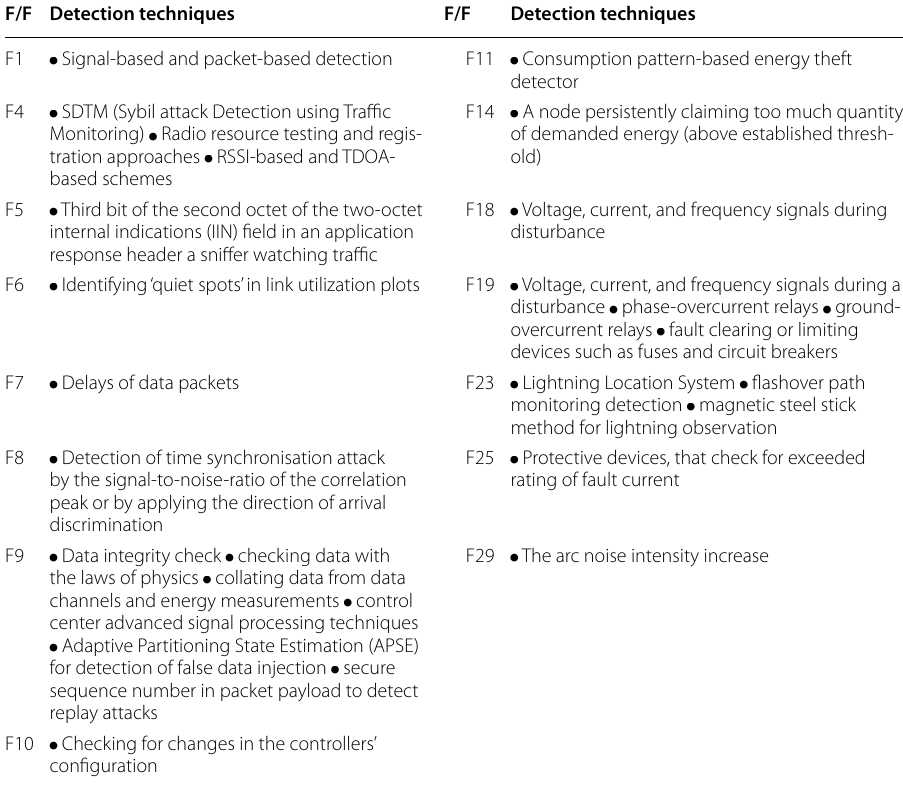
Table 5 RQ5 (Detection techniques for SG faults and